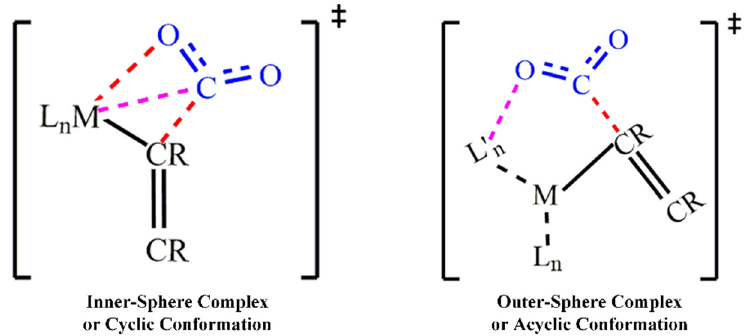
Figure 3. The possible interaction modes for the metal M and CO 2 in CO 2 insertion step.